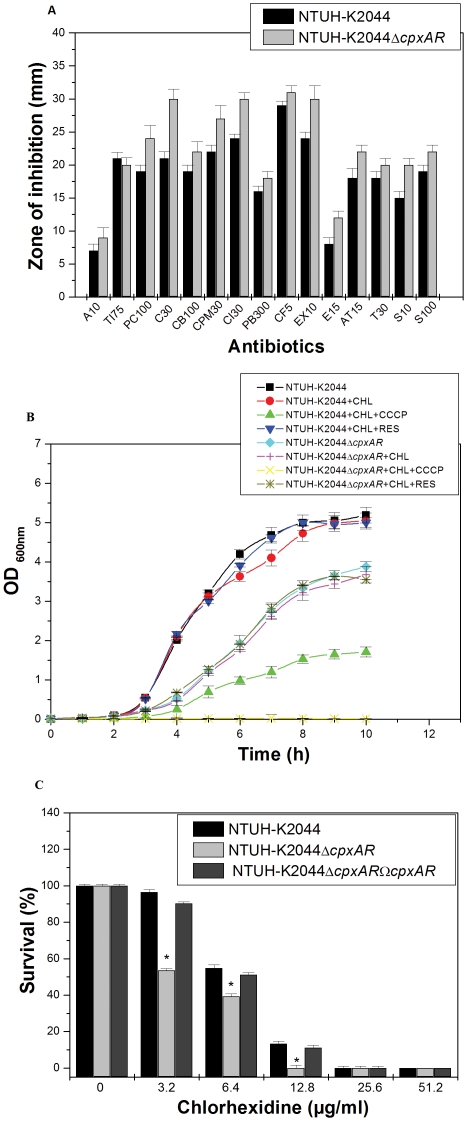
Antibiotic susceptibility testing, in vitro growth inactivation and chlorhexidine challenge assay with NTUH-K2044, NTUH-K2044ΔcpxARand NTUH-K2044ΔcpxARΩcpxAR.
A) The Kirby Bauer disc diffusion assay was performed with different antibiotics (A10, Ti75, PC100, C30, CB100, CPM30, CI30, PB300, CF5, EX10, E15, AT15, T30, S10 and S100) using commercial discs. Data for representative drugs from each class have been shown here. B) Growth inactivation assays using chloramphenicol (0.005 µg/ml). The efflux pump inhibitors CCCP and reserpine were used at a concentration of 10 µg/ml in the experiment. Abbreviations: CHL = chloramphenicol; RES = reserpine; CCCP = cyanide m-chloro phenyl hydrazone. C) Sensitivity towards disinfectant chlorhexidine was monitored by using the agar dilution assay for different concentrations (3.2 µg/ml, 6.4 µg/ml, 12.8 µg/ml, 25.6 µg/ml, 51.2 µg/ml) for the wild-type strain, and cpxAR mutant. The datas are the means of measurements made in triplicate and performed three times. *, Significant difference (P<0.05, Student t test).